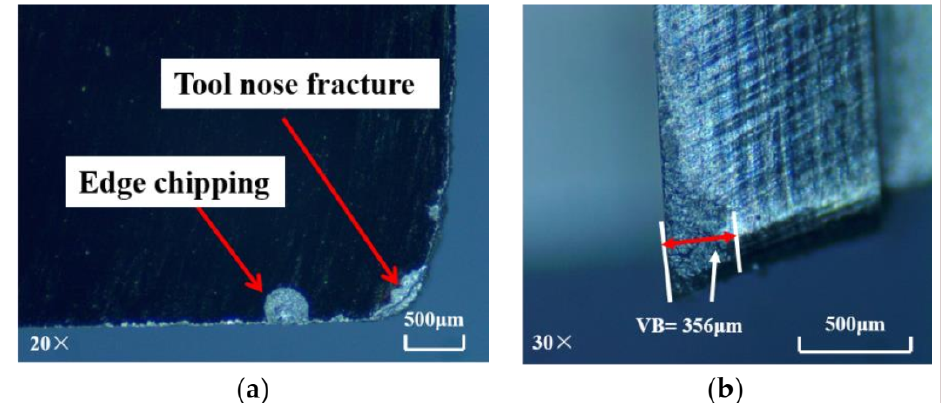
Figure 7. Wear of CVD diamond tool in cryogenic machining: ( a ) rake face; ( b ) flank face (material removal amount = 84 mm 3